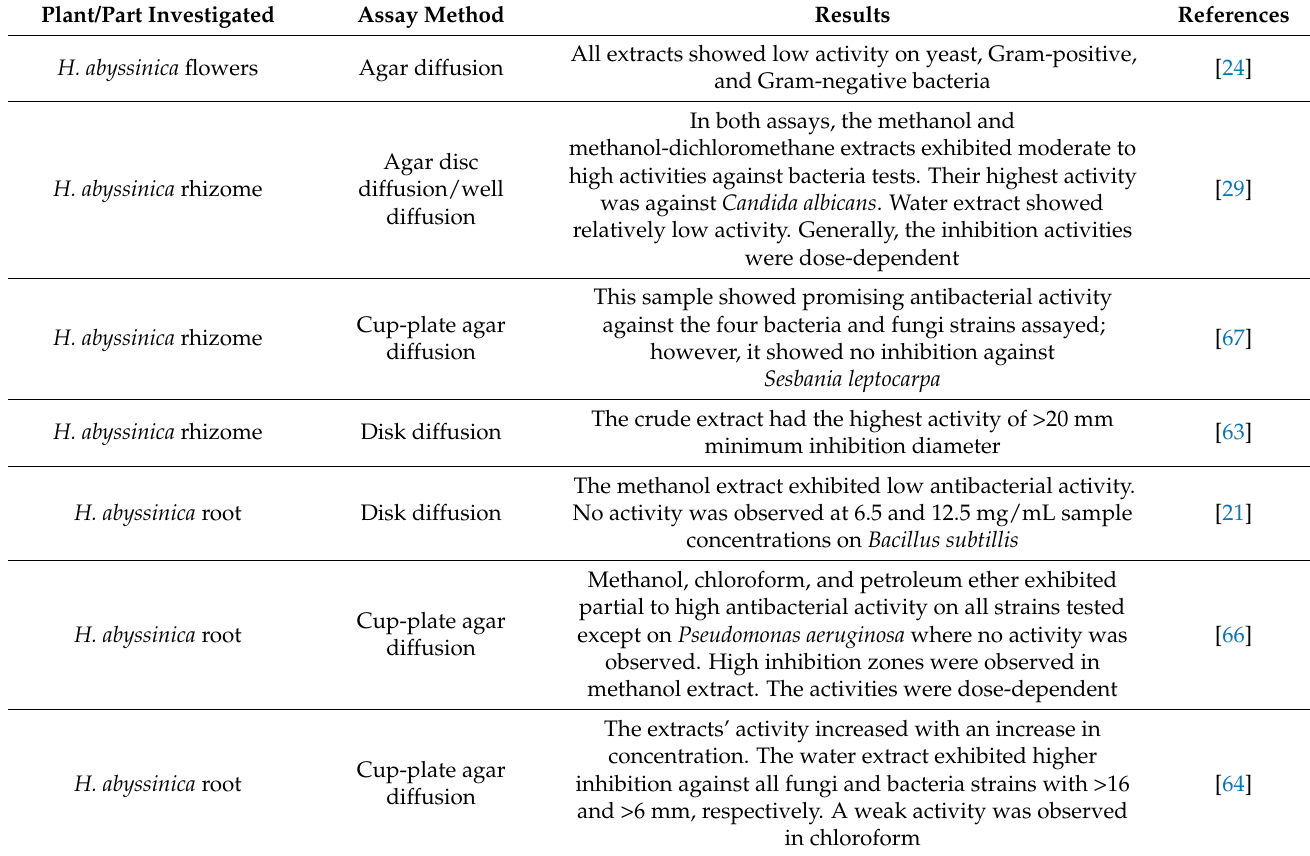
Table 4. Antibacterial and antifungal activities of H. abyssinica and H. africana. Plant/Part